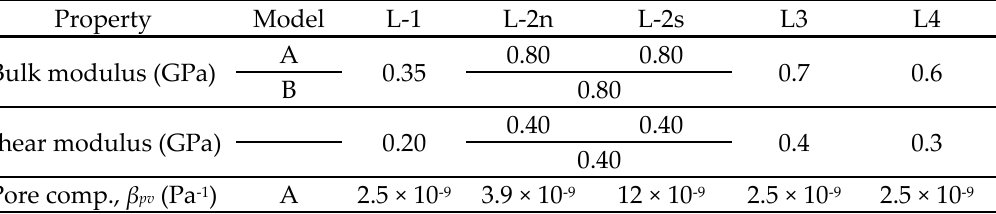
Table 1. Major hydraulic and mechanical